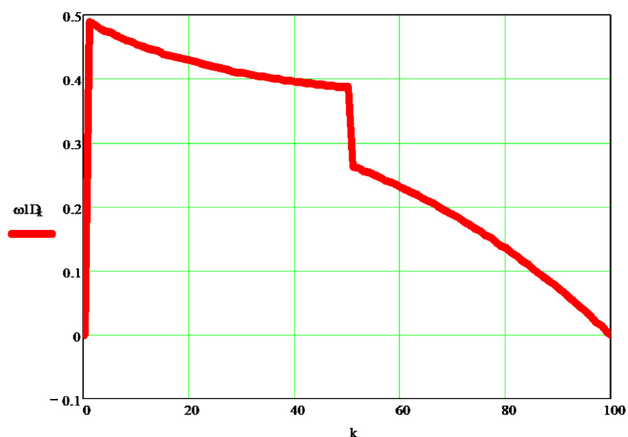
Figure 4. Variations of mass (mechanical) moments of inertia reduced to a coupling B (element 2).